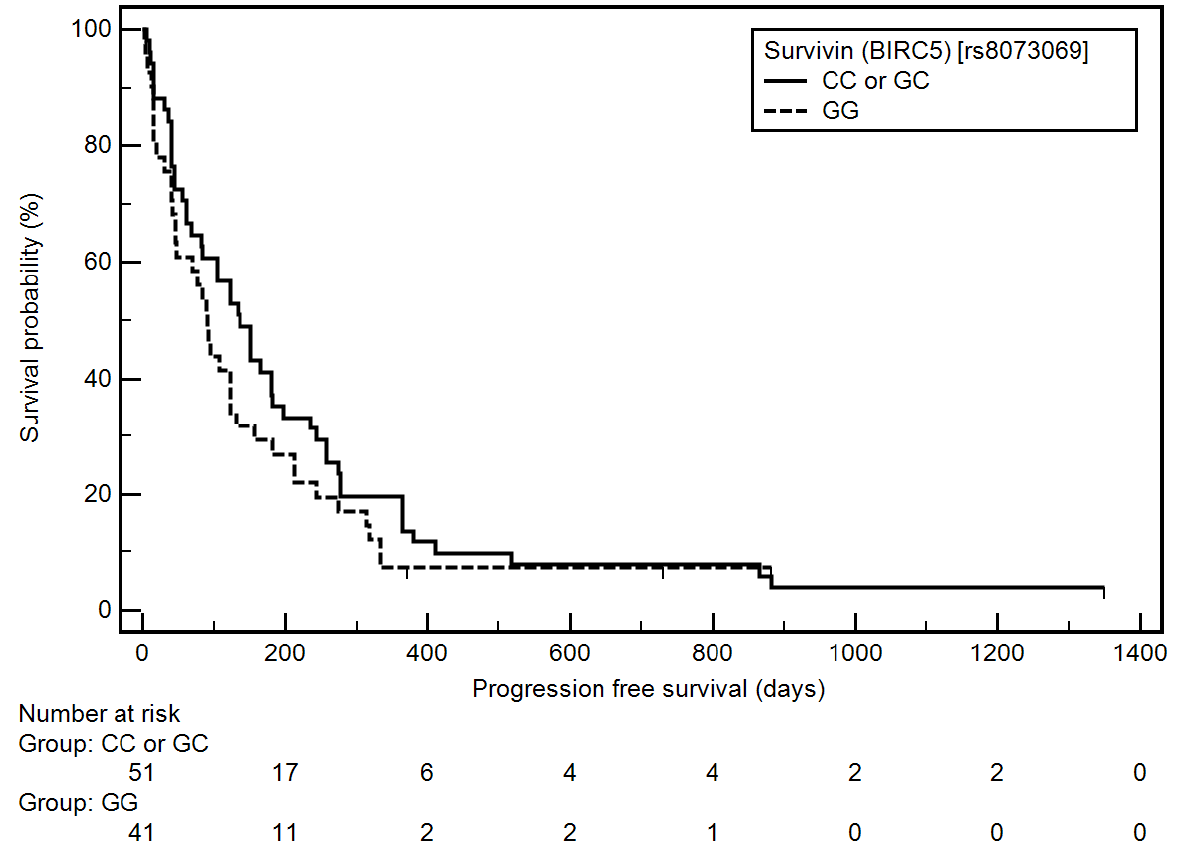
Figure 1. Kaplan–Meier curves representing probability of PFS shortening depending on BIRC5 genotype.